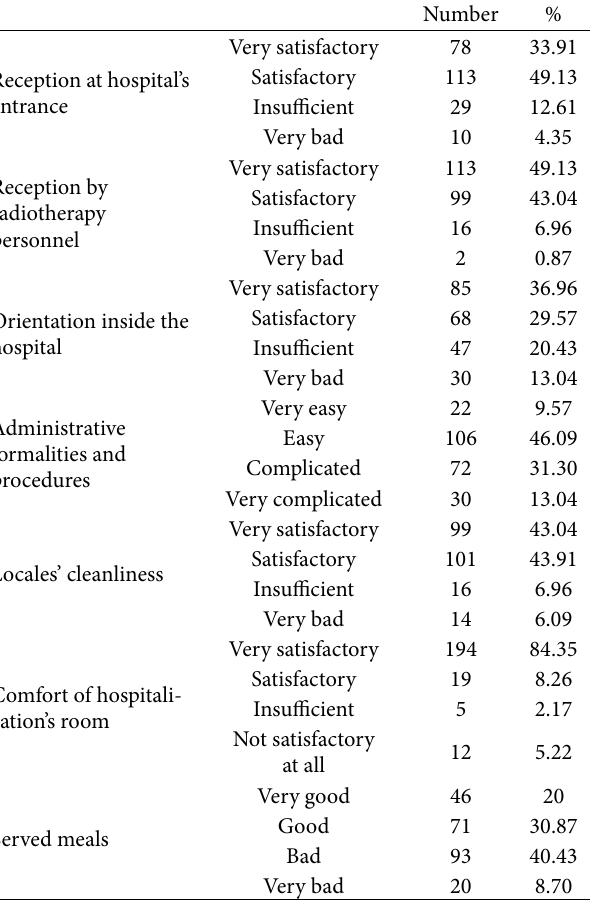
Table 1: Sociodemographic characteristics of cancer patients (Has- san II CHU, Fez, 2017).